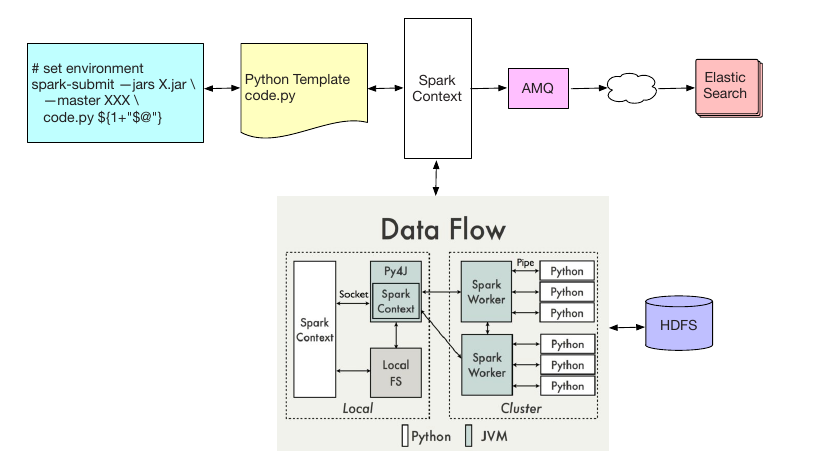
Figure 1. A typical CMSSpark workflow to process data on HDFS cluster via the Spark